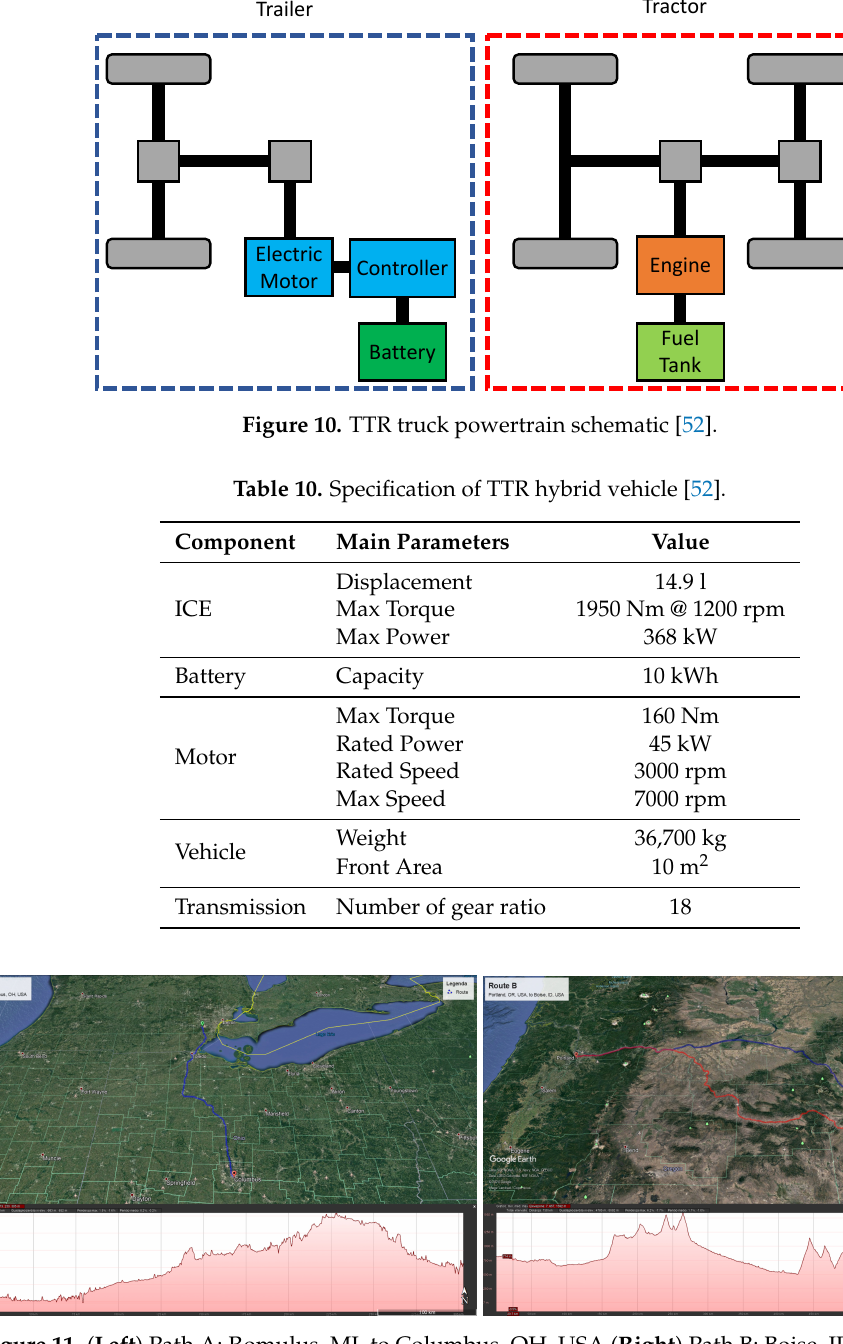
Figure 11. ( Left ) Path A: Romulus, MI, to Columbus, OH, USA ( Right ) Path B: Boise, ID, to Portland, OR, USA